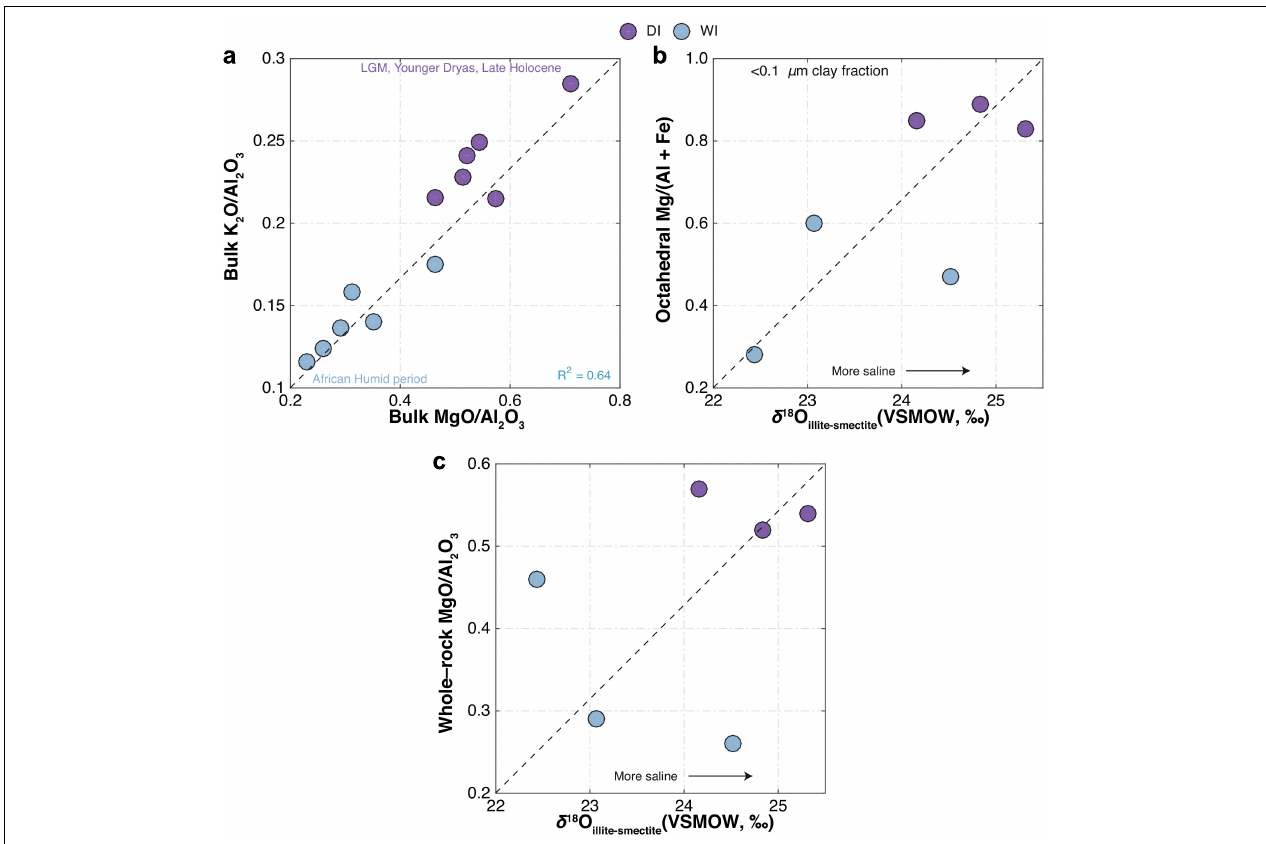
FIGURE 10 | Comparison for DI and WI samples between (a) bulk K 2 O/Al 2 O 3 and MgO/Al 2 O 3 , (b) octahedral Mg/(Al + Fe) versus δ 18 O of authigenic illite-smectite ( < 0.1 µ m size-fraction), and (c) bulk MgO/Al 2 O 3 versus δ 18 O of authigenic illite-smectite ( < 0.1 µ m size-fraction). Arrows in (b,c) show direction of increase in salinity deduced from δ 18 O illite − smectite .